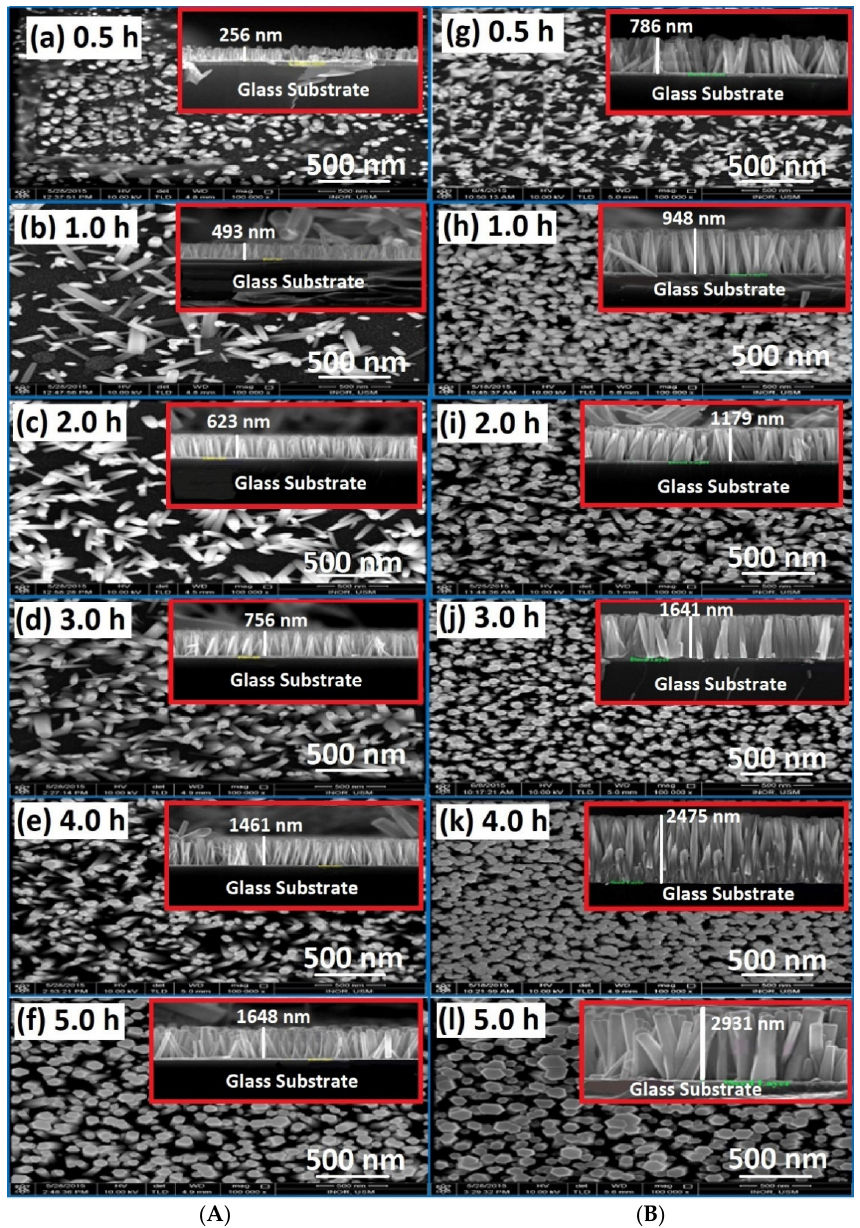
Figure 4. FE-SEM images of ZnO nanorods grownup for different growth periods: ( A ) no air bubbles and ( B ) air bubbles. The inset at the top-right corner represents the cross-section of ZnO nanorods for each growth time representing the cross-section of nanorods. (( a , g ) for 0.5 h, ( b , h ) for 1.0 h, ( c , i ) for 2.0 h, ( d , j ) for 3.0 h, ( e , k ) for 4.0 h, ( f , l ) for 5.0 h growth time respectively).